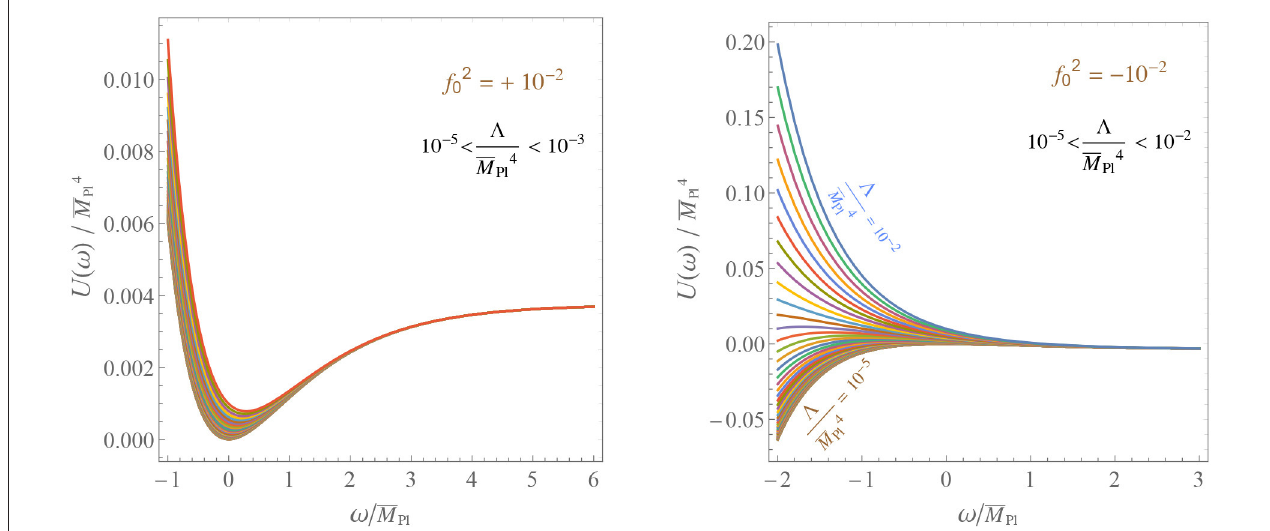
FIGURE 1 | Einstein frame potential as a function of the canonically normalized scalar ω equivalent to the scalar ζ corresponding to the R 2 term in the Lagrangian. The quantity f 2 0 is chosen to be positive (negative) on the left (right). A minimum exists only for f 2 0 > 0, which corresponds to Starobinsky’s inflationary model.